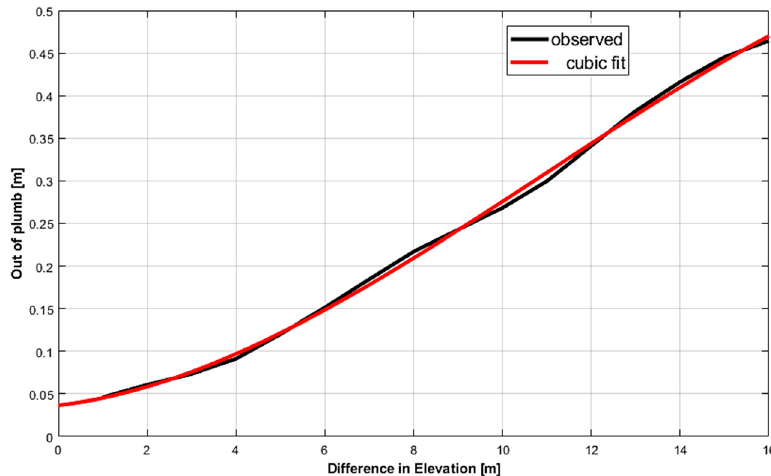
Figure 14. The curvilinear relation between the out of plumb of the minaret body and the successive difference in elevations with respect to the minaret base.